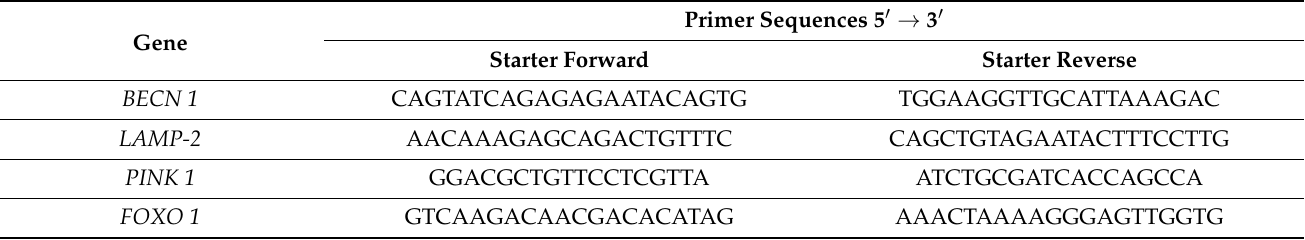
Table 2. Sequences of the primers used for the RT-qPCR